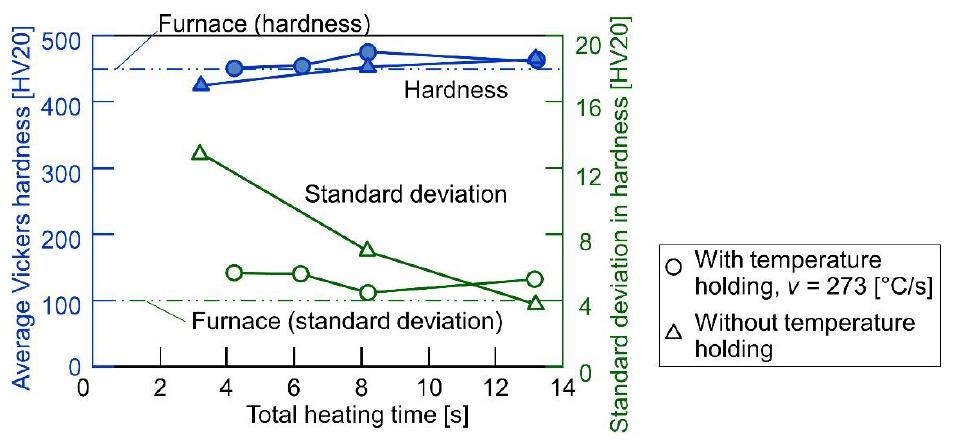
Figure 18. Relationships between Vickers hardness and total heating time with and without holding at 900 °C.